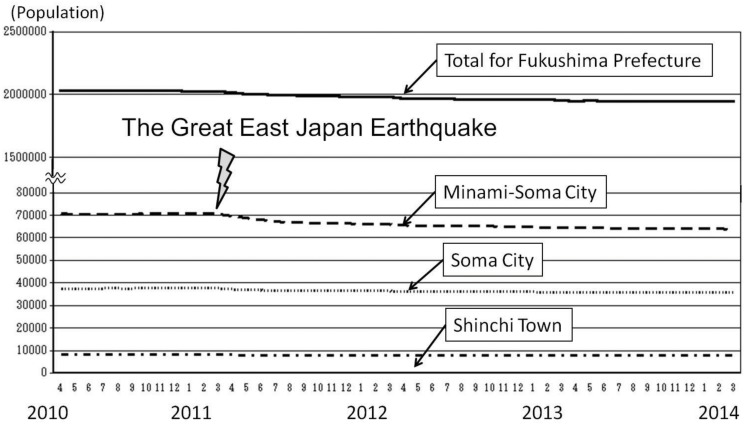
Demographic transition in Soma City, Minami-Soma City, and Shinchi Town (excerpt from Fukushima Prefectural Home Page: http://www.pref.fukushima.lg.jp/).After the disaster, many people voluntarily evacuated to other places without changing their residence registry. The exact number of those refugees has not been counted by the local governments as yet, but the population decreased by 4.4% in Fukushima Prefecture, 5% in Soma City, 9.6% in Minami-Soma City, and 6.9% in Shinchi Town.